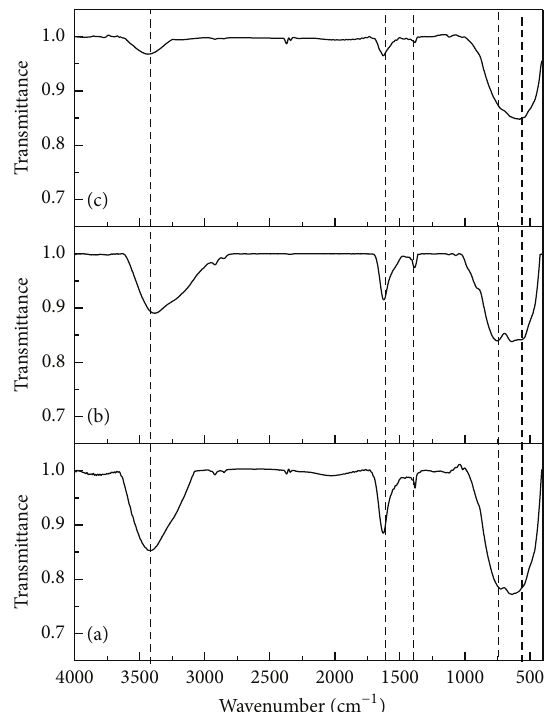
Figure 4: FTIR graphs of synthesized TiO 2 nanoparticles using an activated carbon template in different quantities and with no calcination: (a) 0%, (b) 5%, and (c)